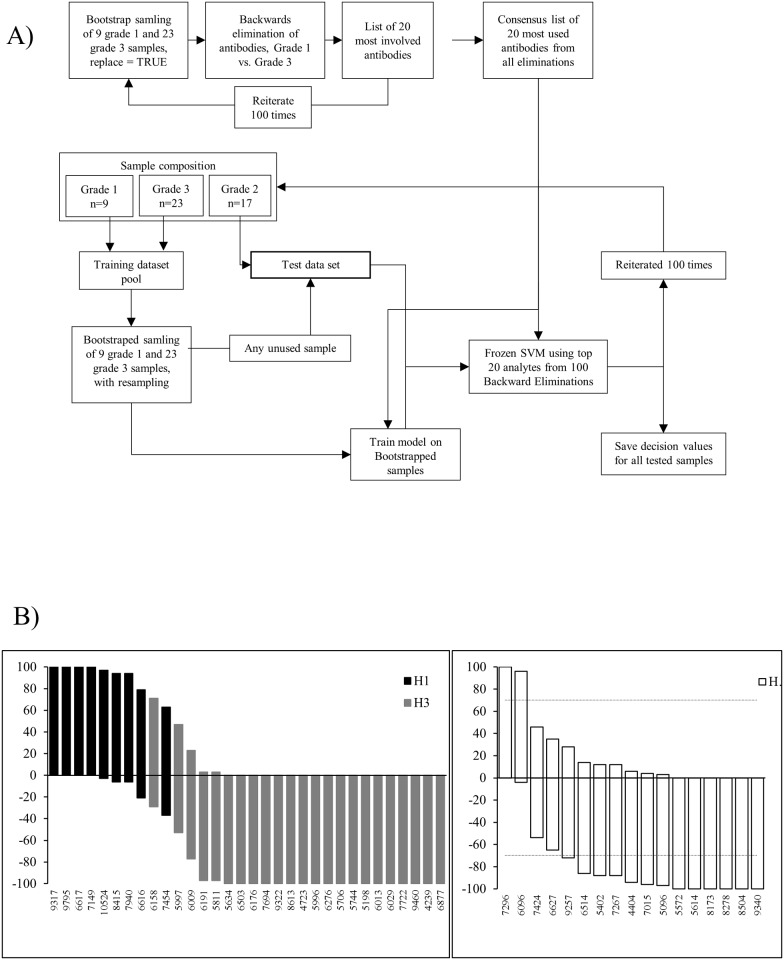
Third model for refined molecular grading of breast cancer.A) Outline of the sample bootstrap strategy and combination with backward elimination and frozen SVM, generating a classification model. B) The classification is shown in terms of number of time a tumor was classified as either grade 1 (positive value) or grade 3 (negative value). A tumor was classified as being more similar to grade 1 when the value was ≥70, <70 to >-70 is defined as a grey zone (i.e. grade 2 tumors), and ≤ -70 are defined as being more similar to grade 3 tumors. The arbitrary cut-limits are indicated by dashed lines. Left panel–classification of grade 1 and grade 3 tumors. Right panel–classification of grade 2 tumors.